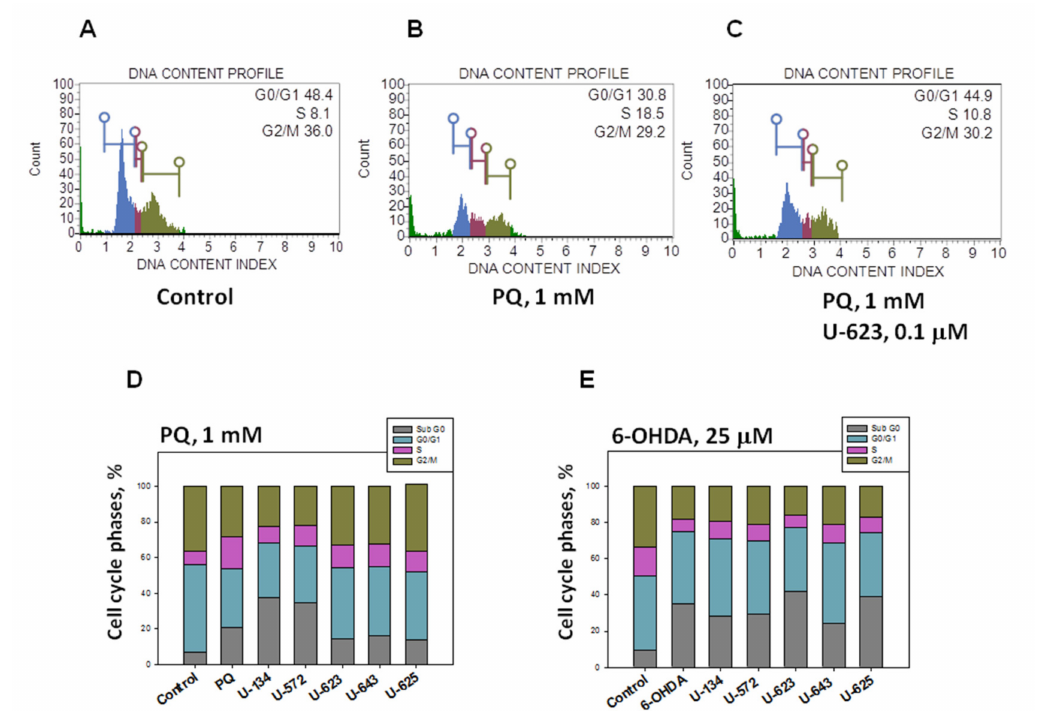
Figure 3. Effect of 1,4-NQs on the Neuro-2a cell cycle altered by PQ and 6-OHDA. Cells (1.5 × 10 5 cells/well in 6-well plates) were incubated with PQ (1.0 mM) or 6-OHDA (25.0 µ M) for 24 h. The cell cycle was analysed using fluorescent flow cytometry. ( A – C ) the figure shows the percentage of cells in each stage of the cell cycle: Control ( A ), PQ, 1.0 mM ( B ), PQ, 1.0 mM, and U-623, 0.1 µ M ( C ). ( D , E ) histogram of cell cycle distribution (%) in Neuro-2a cells exposed to PQ ( D ) or 6-OHDA ( E ) and treated with different 1,4-NQs at a concentration of 0.1 µ M for 24 h. Values are expressed as the means of three different